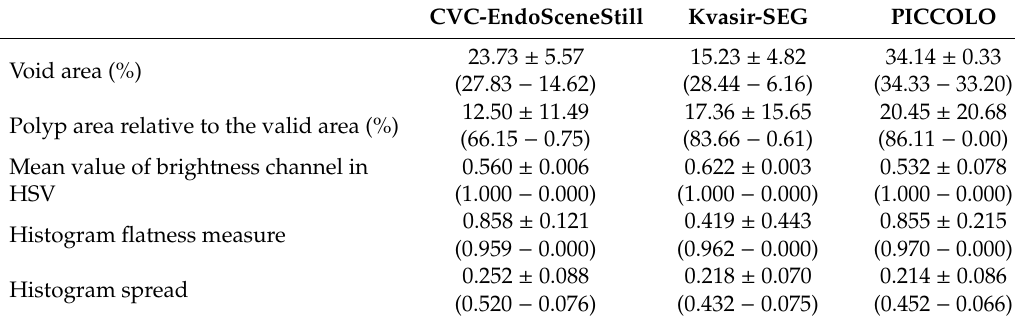
Table 3. Characterization of the datasets. Results are reported as mean ± standard deviation. Minimum and maximum values are indicated between brackets. The void area refers to the black area in the images (Figure 2), while the remaining area is considered as valid area.